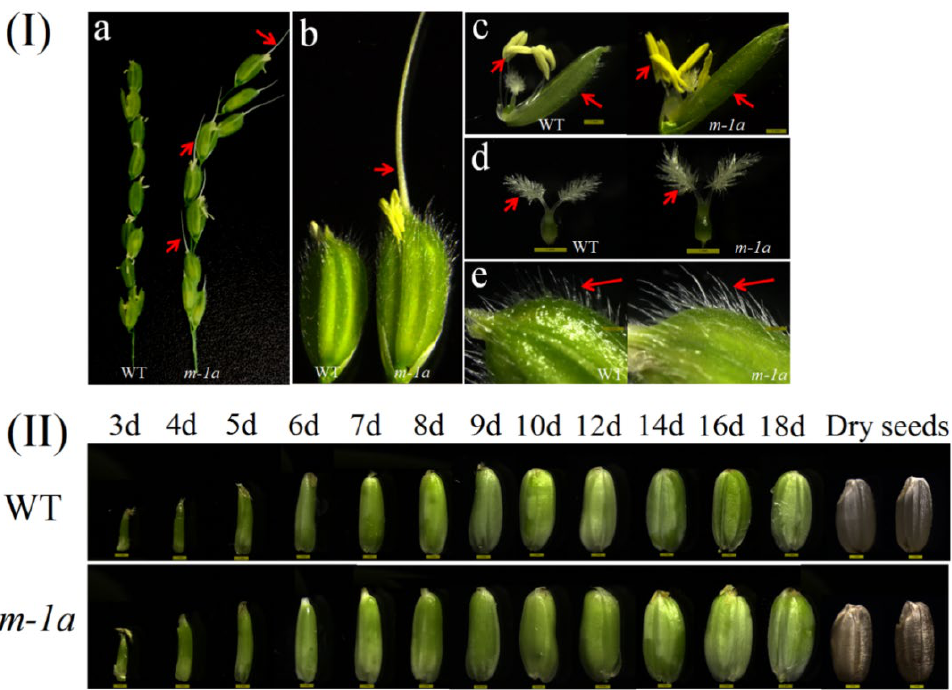
Figure 2. Phenotype analysis of T 3 m-1a plants. ( I ) Different phenotypes: ( a ) panicles, ( b ) hulls, ( c ) stamens, ( d ) pistils and ( e ) glume hairs. ( II ) Developmental stages of T 3 seeds. WT = wild-type plants (‘Zhonghua 11’). Bars = 1 mm.